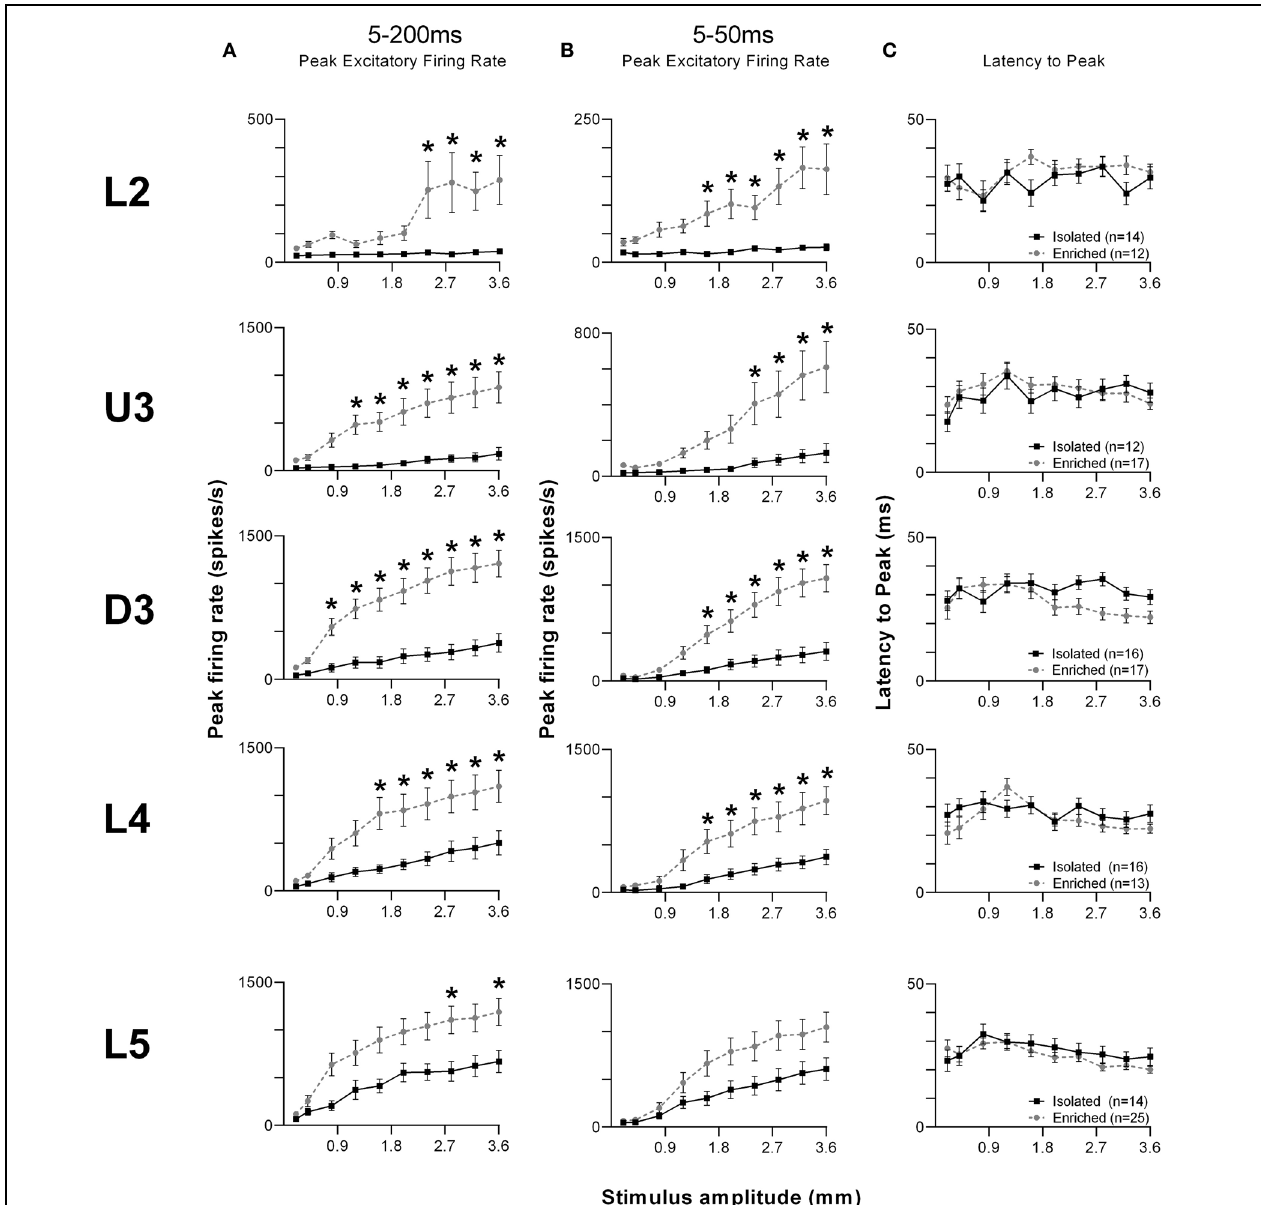
window. No changes in response timing were found. Data represents averages from all responsive clusters ( ± SEM) at all tested stimulus amplitudes, separated by cortical lamina. Laminar designations: L2, Layer 2; U3, Upper Layer 3; D3, Deep Layer 3; L4, Layer 4; L5, Layer 5. Each row of data comes from the same lamina as designated by the labels on the left; cluster numbers for each layer are listed in the key in the last column. ∗ p < 0 .